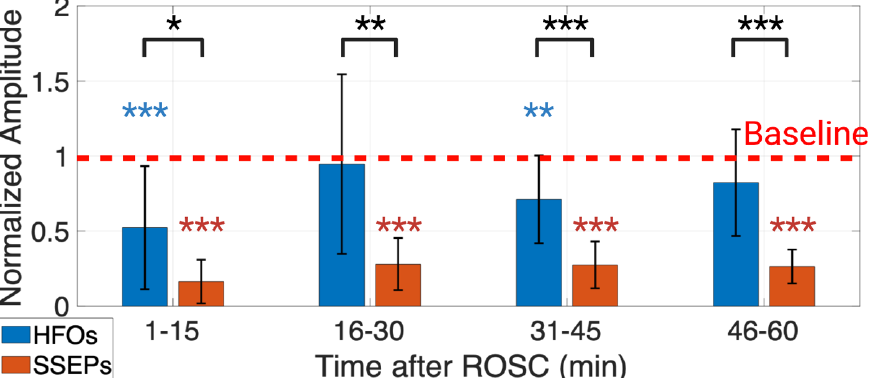
Figure 4. Normalized HFO peak-to-peak amplitudes recovered earlier and more robustly than normalized SSEP peak-to-peak amplitudes in the first 60 min post-ROSC ( n = 11 subjects). The two-way repeated measure ANOVA test followed by a post hoc analysis found that the SSEP peak-to-peak amplitude was significantly different than baseline for the entire 60 min post-ROSC, and the HFO peak-to-peak amplitude was only significantly different for 1–15 min and 31–45 min post-ROSC. The difference between HFO and SSEP peak-to-peak amplitudes was statistically significant for all 60 min. * p < 0.05, ** p < 0.01, and *** p < 0.001. Created with Biorender.com.